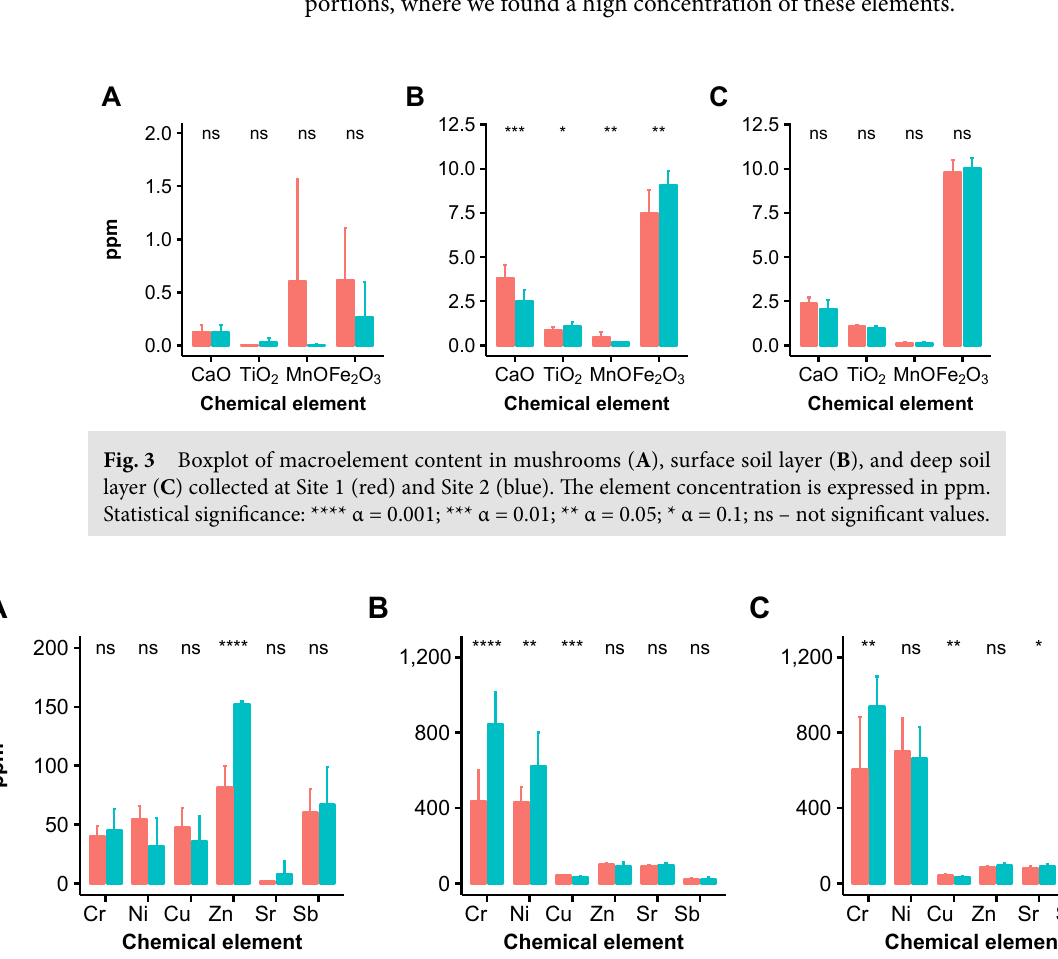
Fig. 4 Boxplot of microelement content in mushrooms ( A ), surface soil layer ( B ), and deep soil layer ( C ) collected at Site 1 (red) and Site 2 (blue). Element concentration is expressed in ppm. Statistical significance: **** α = 0.001; *** α = 0.01; ** α = 0.05; * α = 0.1; ns – not significant